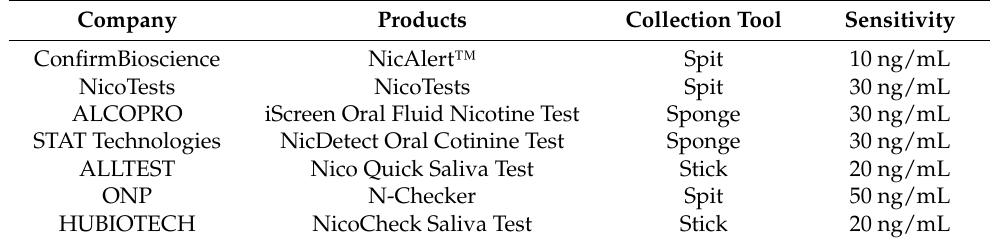
Table 2. Comparison of the gap-LFIA and commercialized saliva cotinine